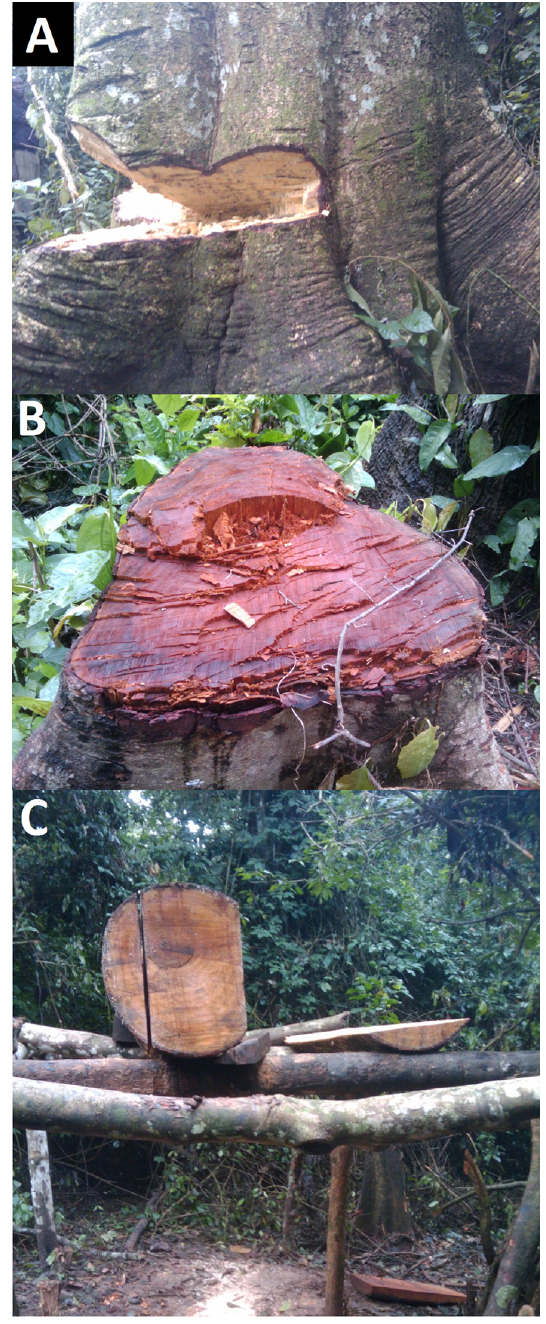
Fig. 4. Stages of timber harvest in Rwensama Forest, Uganda. (A) A tree in the process of being felled. The notch cut is irregular because it is made with an axe rather than a saw. (B) A cut stump. (C) A pit-sawing site. The log to be sawn into boards is propped above the ground so that a two-person crosscut saw can be used. One sawyer stands on top of the log and the other below the